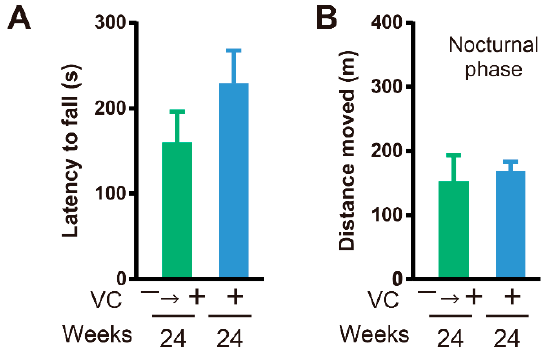
Figure 5. VC supplementation restored physical ability. ( A ) Grasping strength of the VC(+) and VC( − ) → (+) groups at twenty-four weeks. n = 8 mice in the VC(+) group and n = 10 mice in the VC( − ) → (+) group. ( B ) Activity in the cage. n = 6 mice in the VC(+) group and n = 8 mice in the VC( − ) → (+) group. Values are given as the mean ± SEM. Statistical differences were considered significant at p < 0.05 between VC(+) and VC( − ) groups.